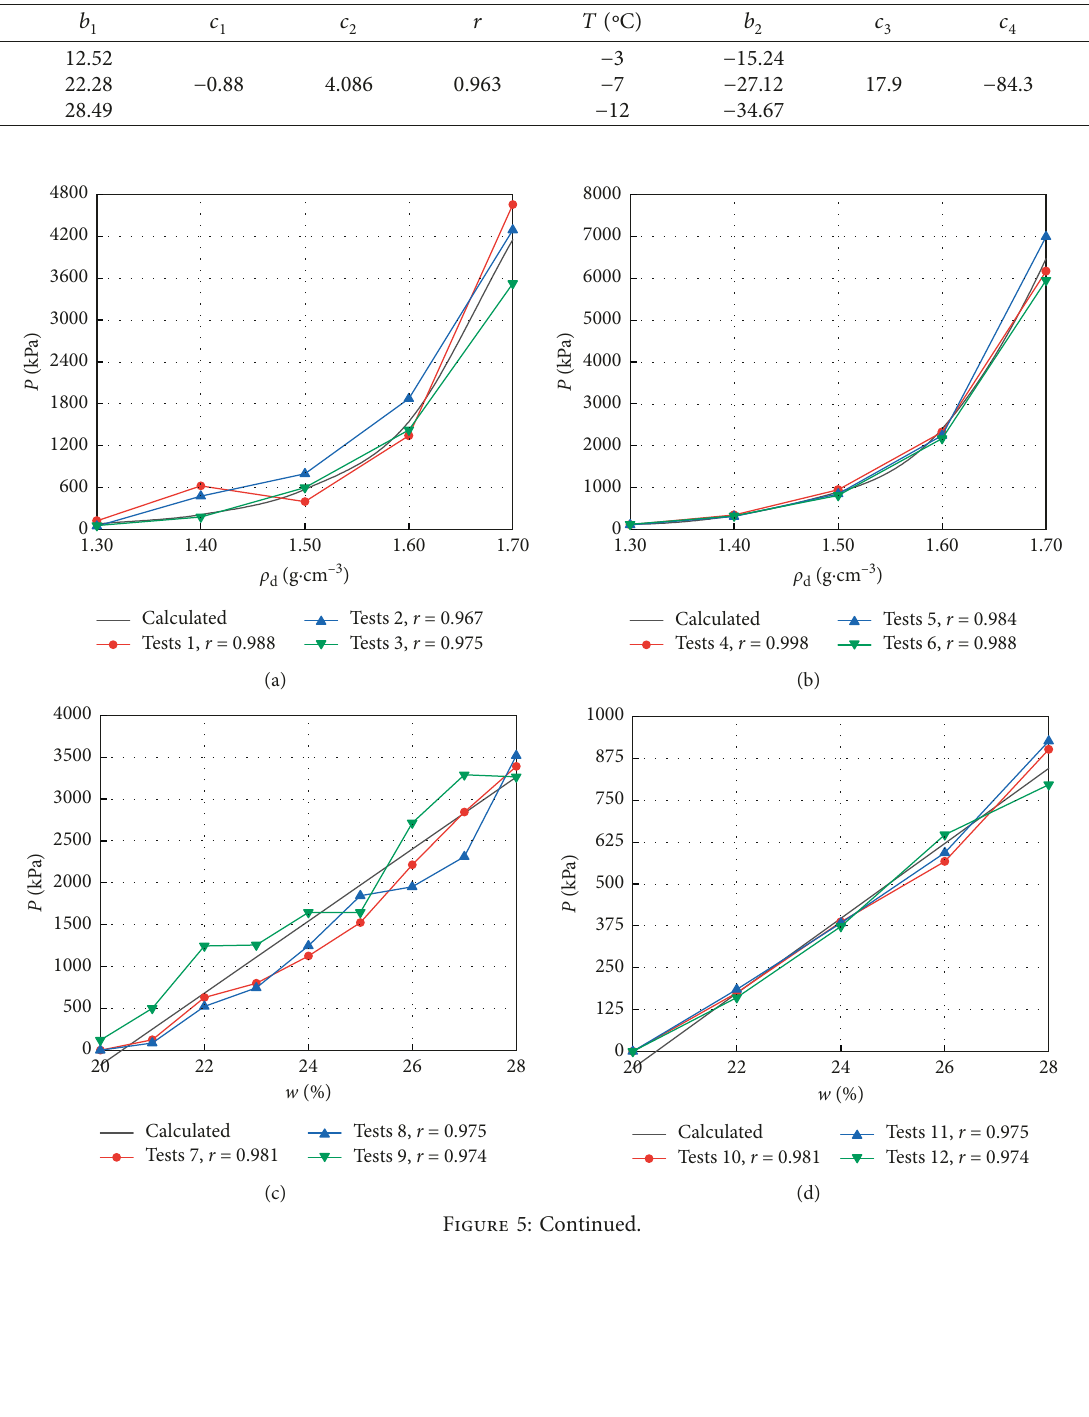
Table 7: Values for parameters c